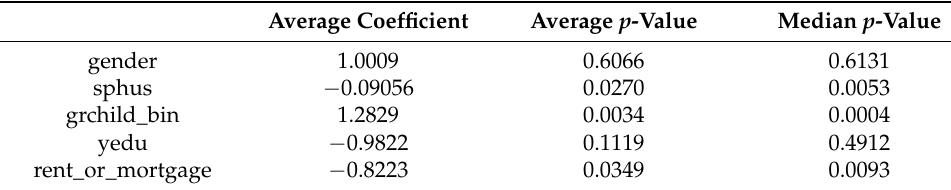
Table 8. Results from simulated Cox regressions of retirement ( n =